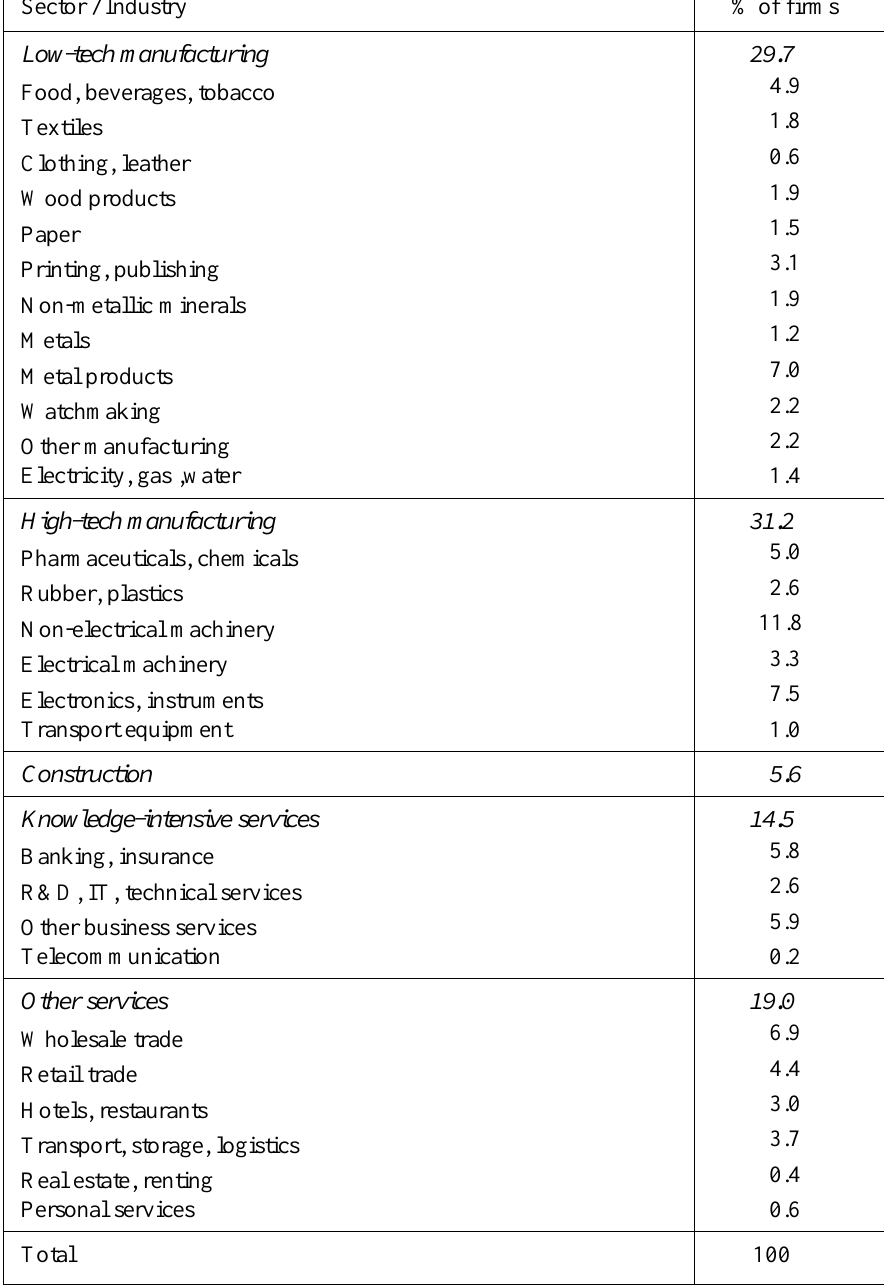
Table A.1 : Composition of the final sample by